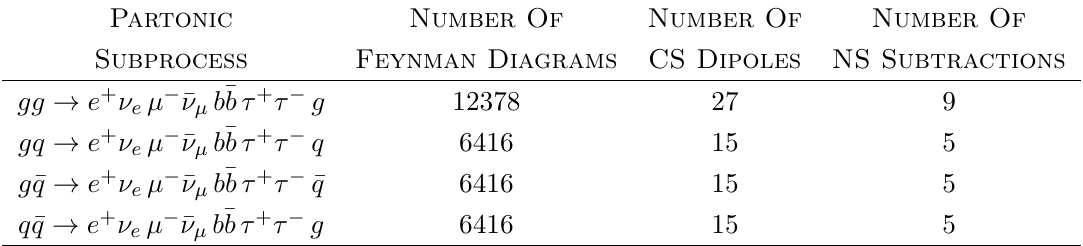
Table 3 . List of partonic subprocesses contributing to the subtracted real emission at O ( α 3 for the pp → e + ν e µ − ¯ ν µ b ¯ b τ + τ − + X process where q = u, d, c, s . Also shown are the number of Feynman diagrams, as well as the number of Catani-Seymour and Nagy-Soper subtraction terms that correspond to these partonic